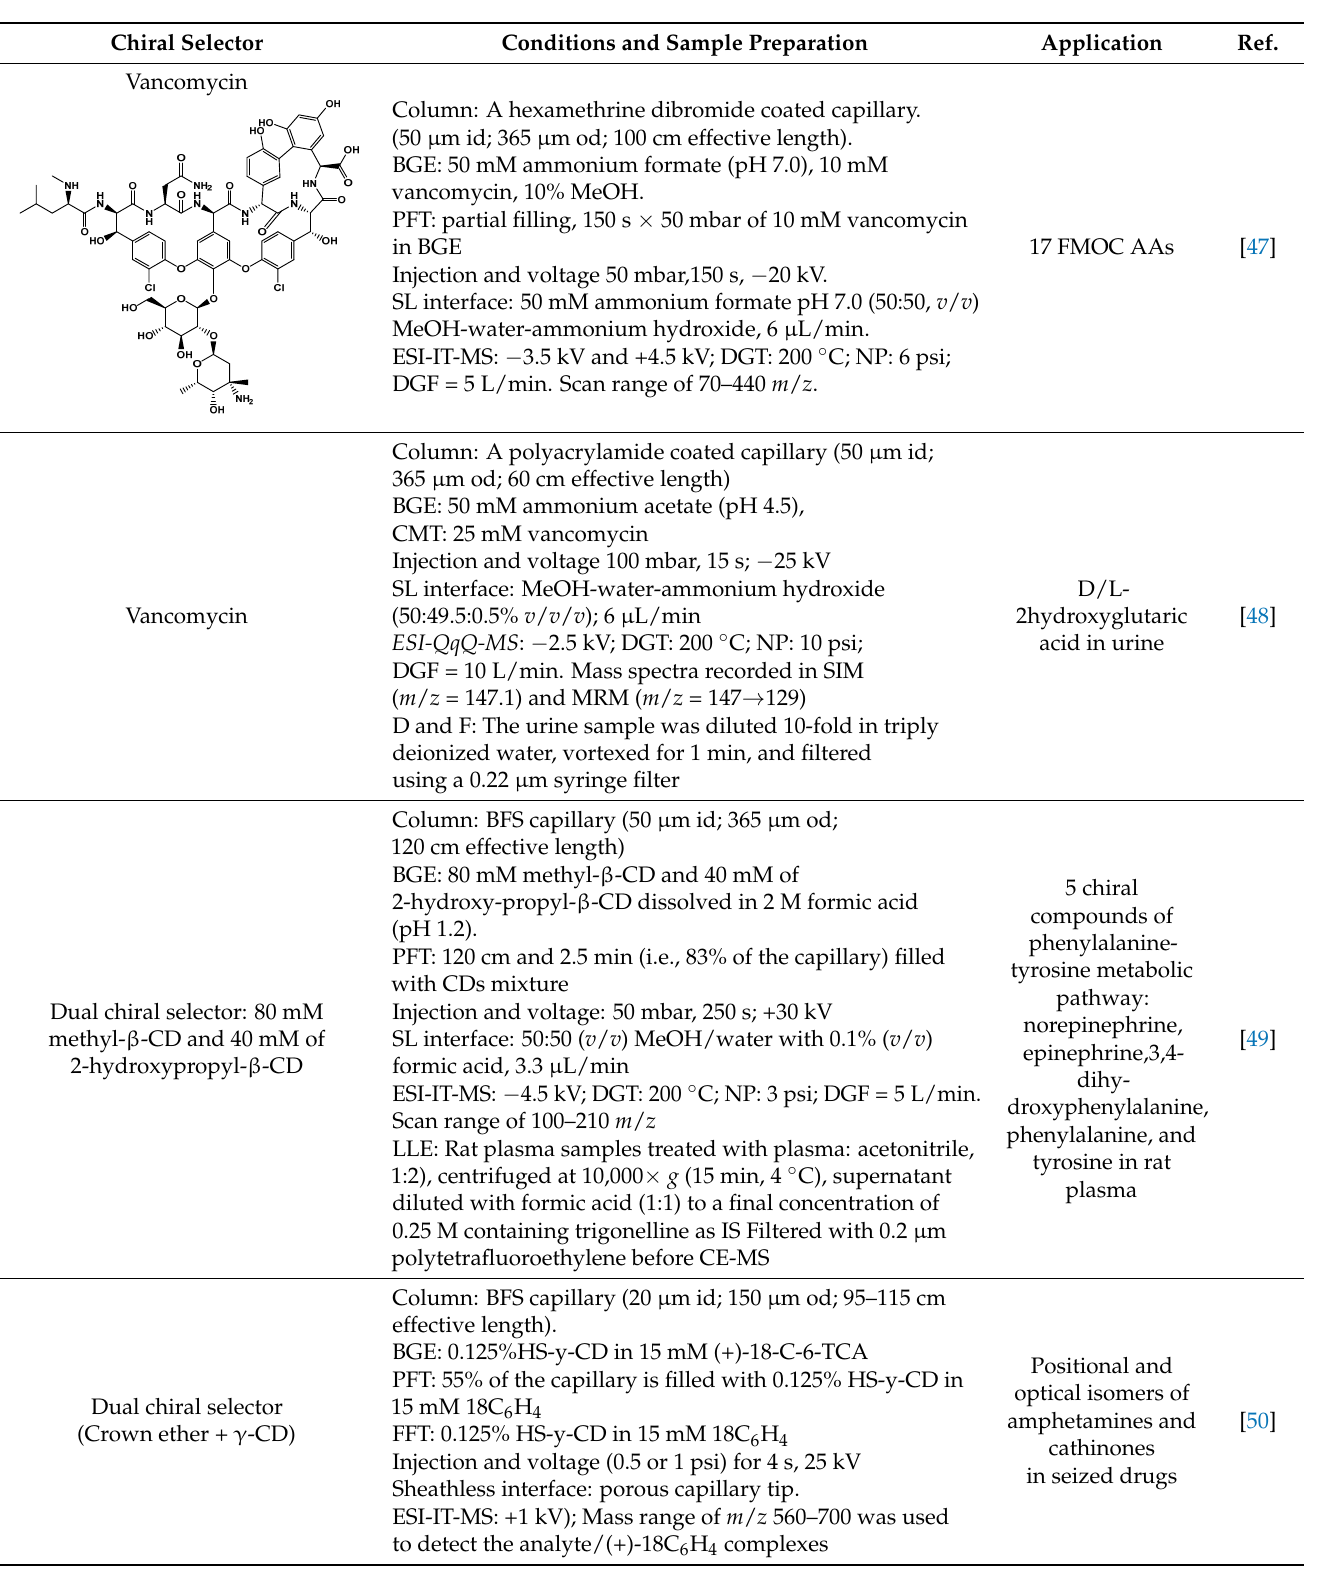
Table 1. Cont. Chiral Selector Conditions and Sample